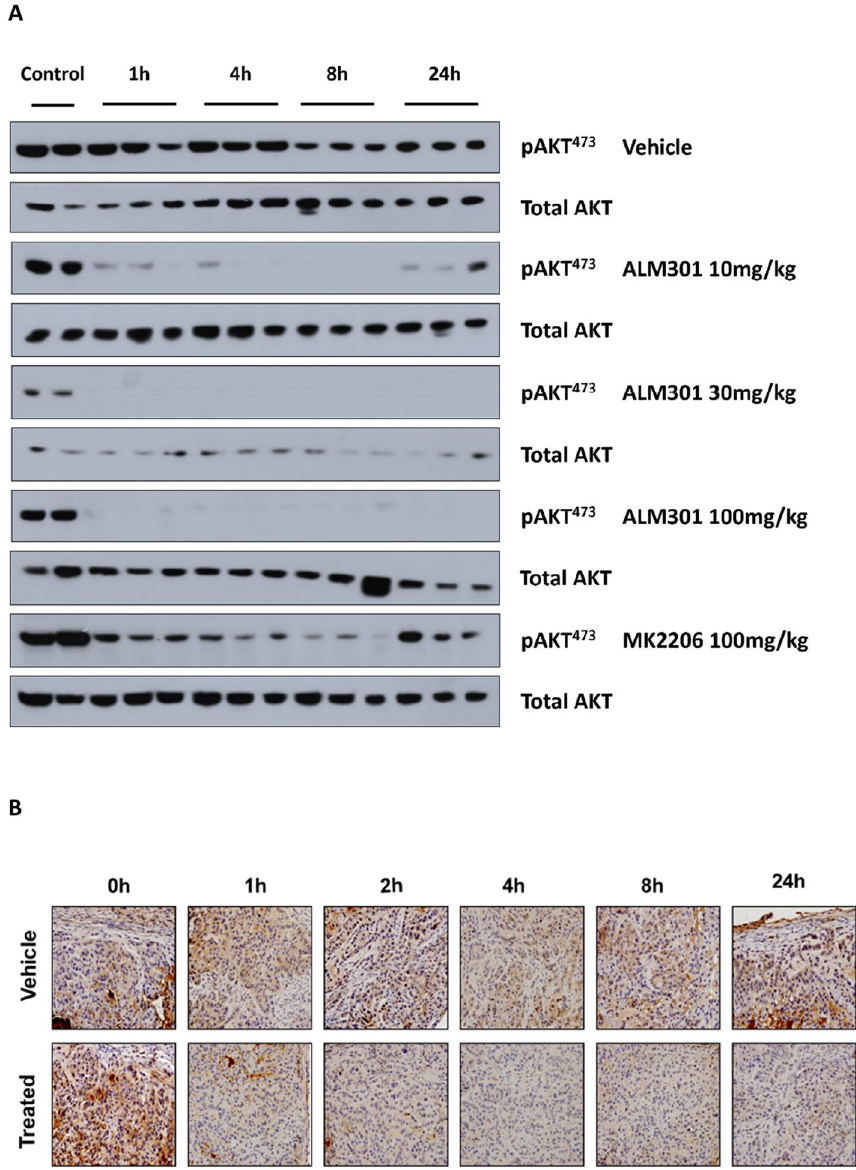
Figure 4. PK/PD and efficacy studies using development candidate ALM301 in A549 and MCF-7 xenograft models. ( A ) PK/PD relationship for ALM301 in A549 lung cancer xenograft model analysing levels of pAKT S473 in tumours using western blotting over 24 h after a single oral dose of either ALM301 (10, 30 or 100 mg/kg) or MK-2206 (100 mg/kg). ( B ) Representative immunohistochemistry sections of phospho AKT stained tumour samples (brown) treated with a single dose of either vehicle only or 30 mg/kg of ALM301 over 24 h period ( C ) Growth inhibition curves in an A-549 tumour xenograft model treated with either vehicle (p.o., q.d. × 28, n = 10/group) or ALM301 (p.o. 10/30 mg/kg q.d. × 28 or p.o. 100 mg/kg q.d × 3 then q.o.d. × 25, n = 10/group). Paired t -test was used to derive p values (n = 10/group), * p < 0.05, ** p < 0.01, *** p < 0.001. ( D ) Growth inhibition curves of MCF-7 tumours treated with either vehicle (p.o., q.d. × 49, n = 10/group), ALM301 (p.o. 3 or 10 mg/ kg q.d. × 49 n = 10/group), tamoxifen (p.o. 5 mg/kg q.d. × 49, n = 10/group) or ALM301 (p.o. 3 or 10 mg/kg q.d. × 49 n = 10/group) in combination with tamoxifen (p.o. 5 mg/kg q.d. × 49). Paired t -test was used to derive p values (n = 10/group), * p < 0.05, ** p < 0.01, *** p < 0.001. ADME: Absorption, distribution, metabolism,